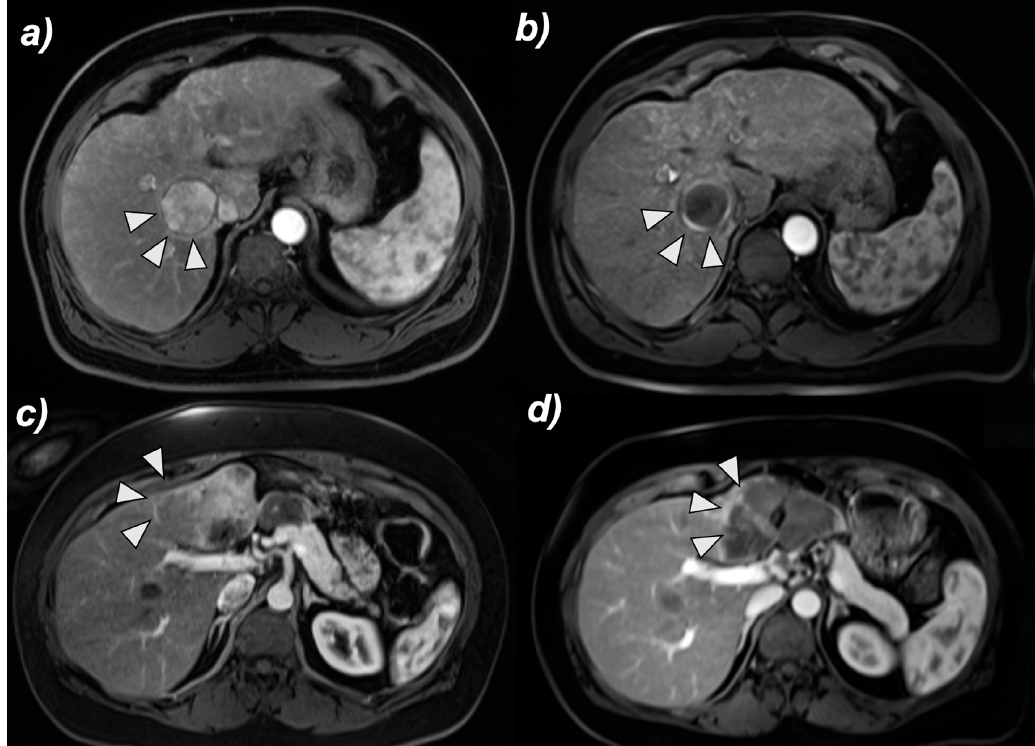
Figure 4. Imaging-based response of nodular and infiltrative HCC to TACE. Representative contrast-enhanced MR images of a nodular HCC treated ( a ) with DEB-TACE (upper row) and an infiltrative HCC ( c ) treated with cTACE (lower row), both showing good local tumor response on follow-up MRI after 4 weeks ( b , d ). Arrowheads indicate tumors on arterial-phase MRI scans. Hepatocellular carcinoma, HCC; DEB-TACE, drug-eluting beads TACE; cTACE, conventional transarterial chemoembolization.